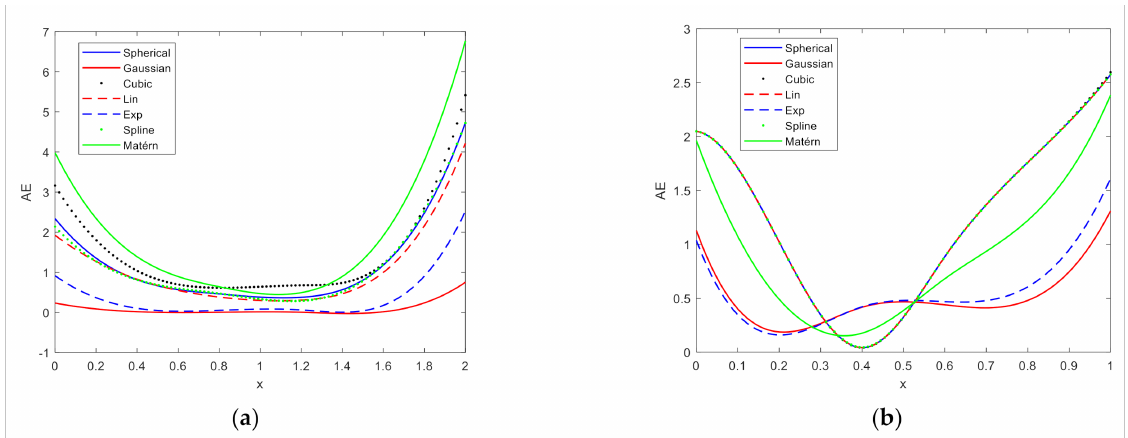
Figure 2. ( a ) AE of Kriging approximation functions in the three-dimensional question; ( b ) AE of Kriging approximation functions in the five-dimensional